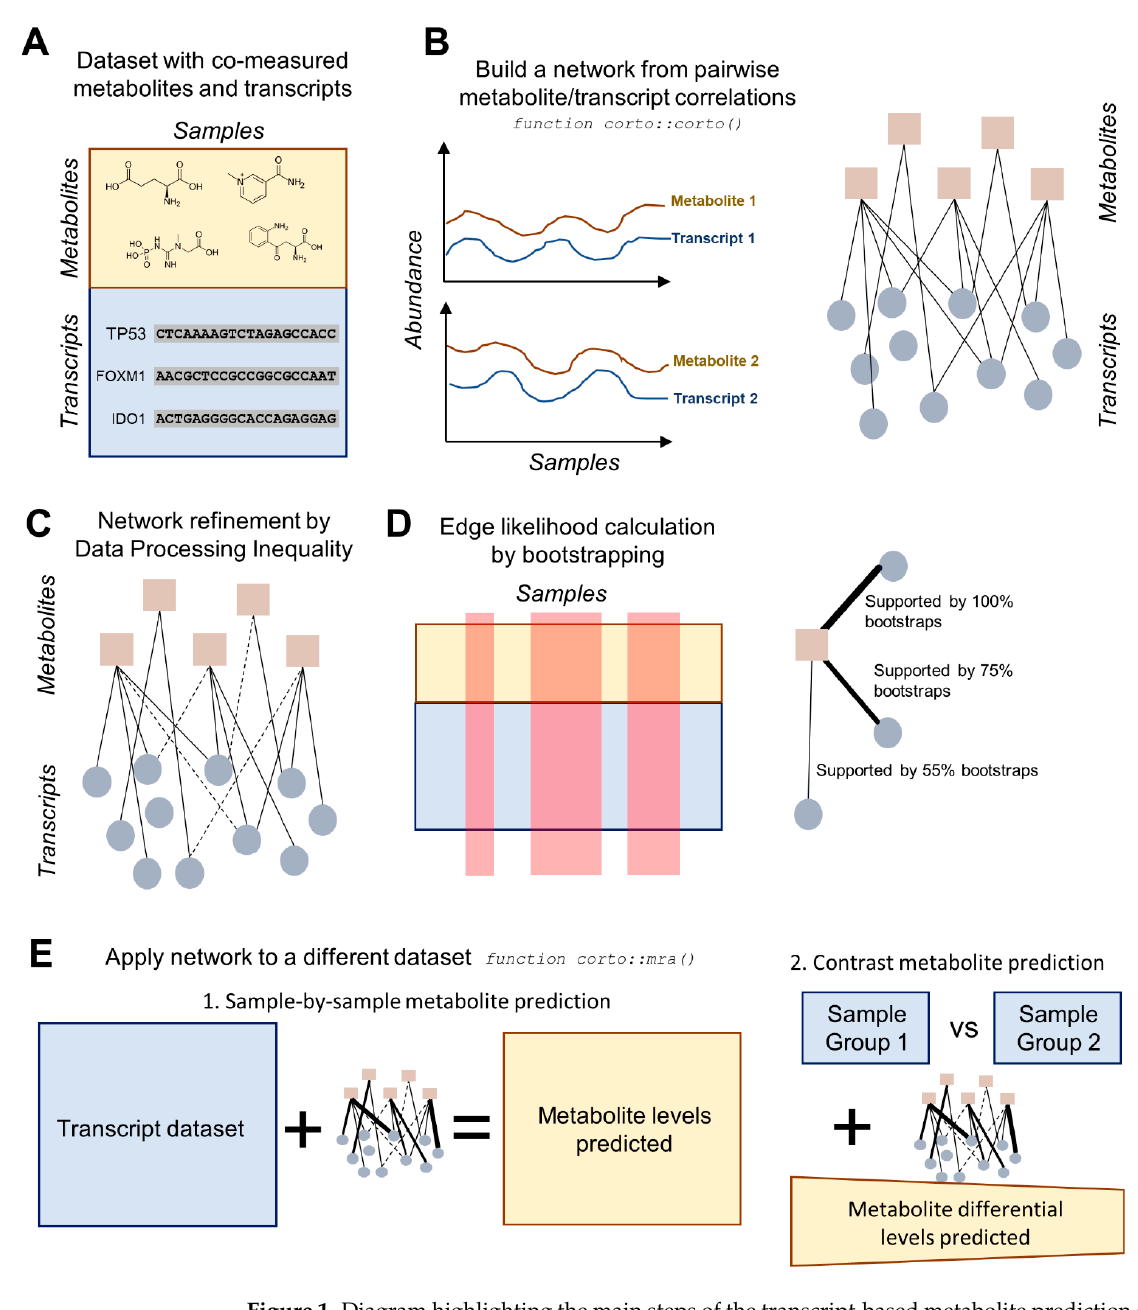
Figure 1. Diagram highlighting the main steps of the transcript-based metabolite prediction approach. ( A ) The starting point must be a dataset with metabolites and transcripts co-measured